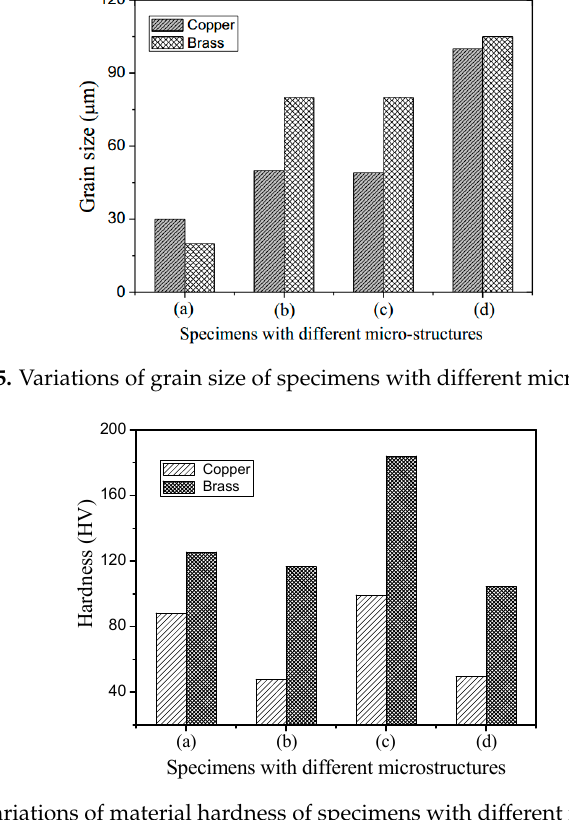
Figure 6. Variations of material hardness of specimens with different microstructures.